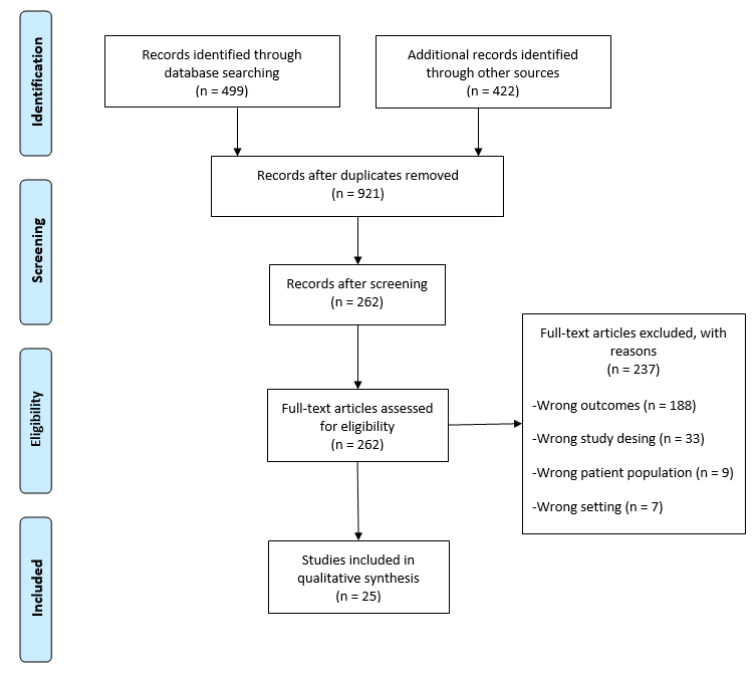
Figure 1. PRISMA flow diagram.